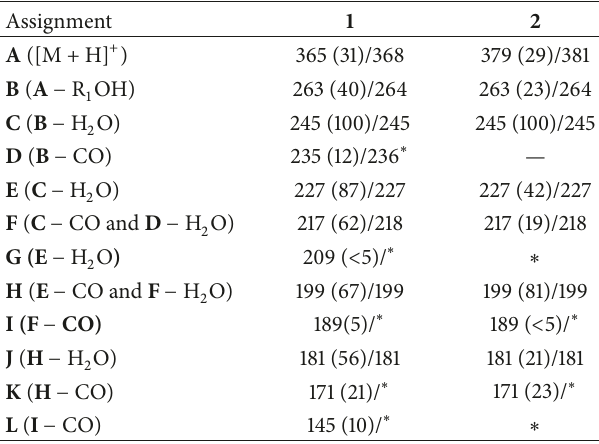
Table 1: Assignments of the main product ions of the protonated epoxyeudesmanolides 1 and 2 and their respective relative intensi-